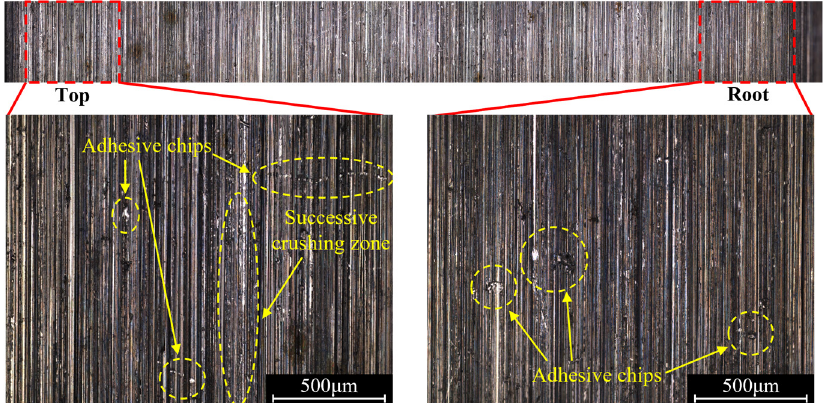
Figure 9. Surface morphology of tooth tip and tooth root.